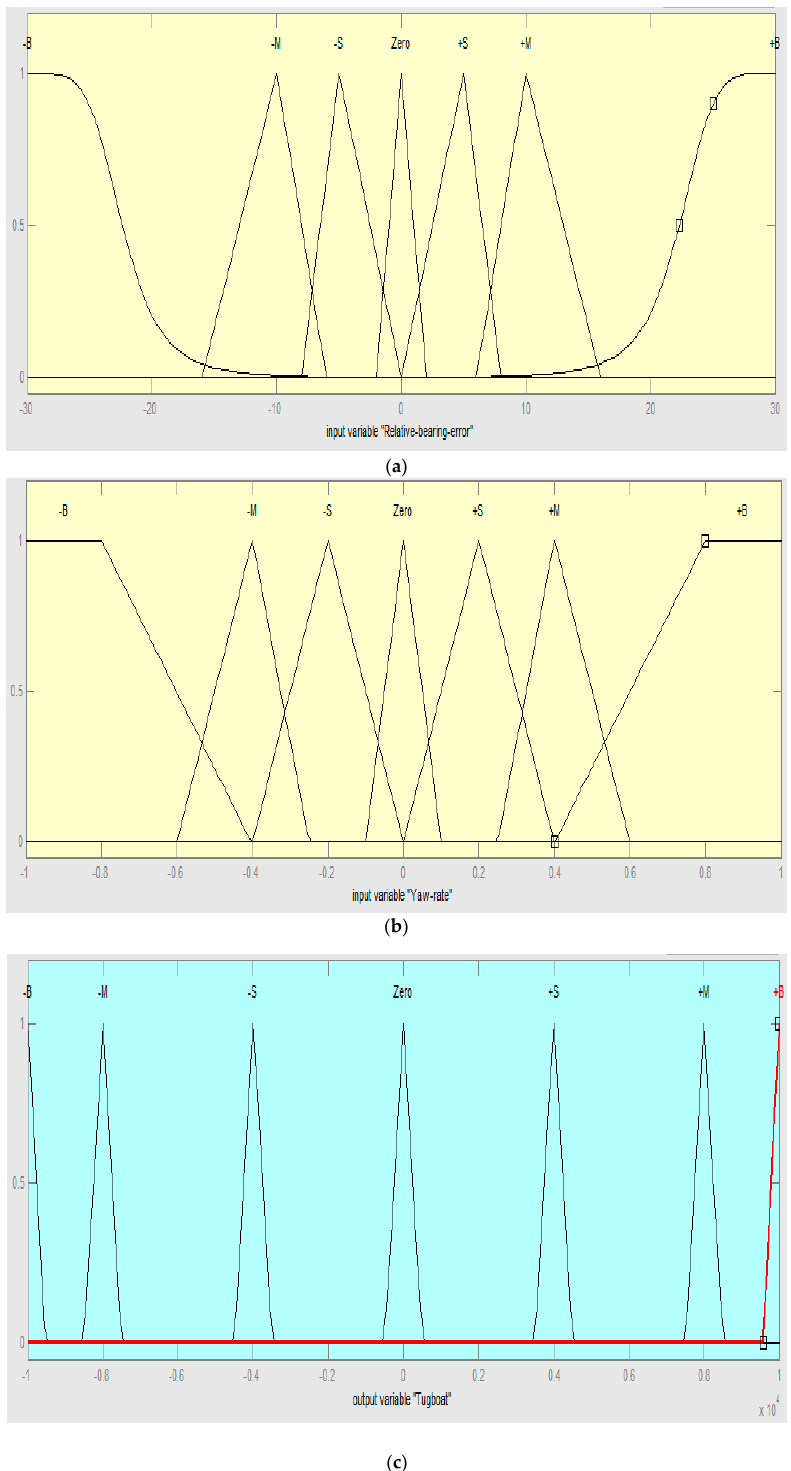
Figure 8. The membership functions of inputs and output data of second fuzzy controller: ( a ) Relative bearing error; ( b ) yaw rate; ( c ) tugboat force.